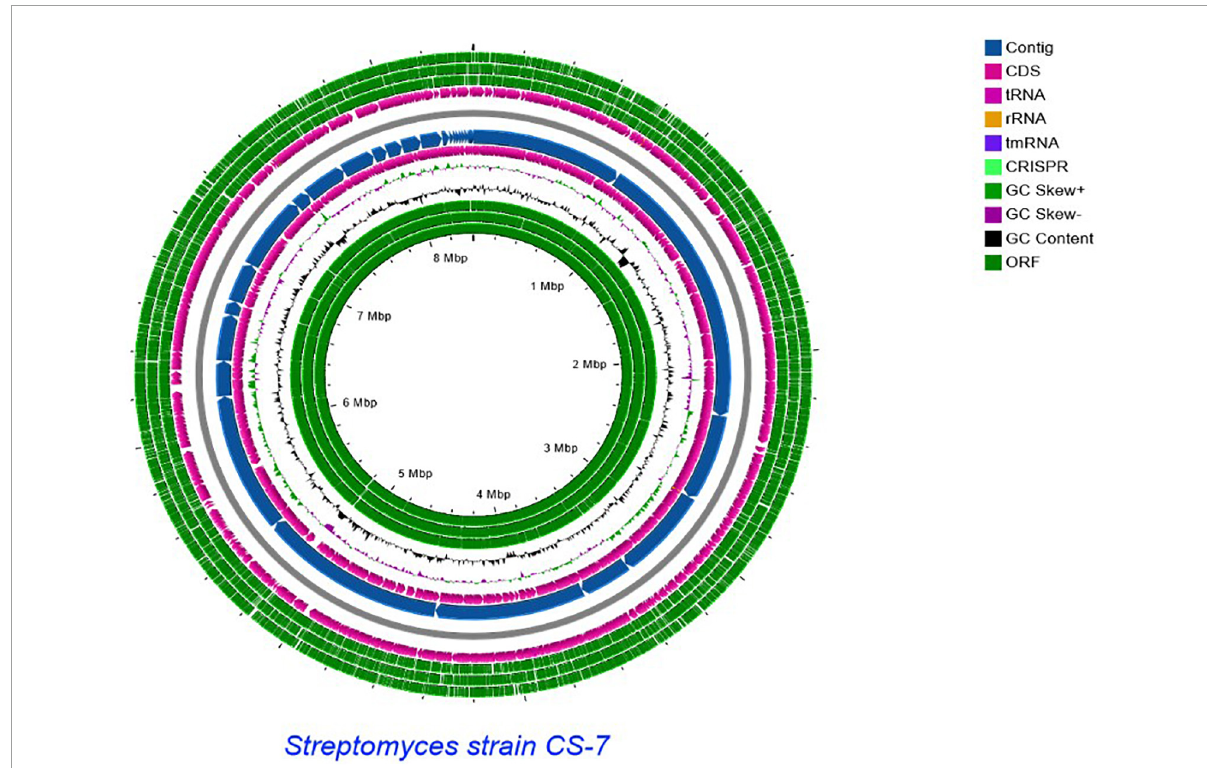
FIGURE6 Schematic representation of the linear chromosome of Streptomyces strain CS-7, created by CG View server (http://cgview.ca/). Circles 1, 2, and 3 display the ORFs. Circle 4 displays the CDS. Circle 6 displays the contigs. Circle 5 displays the tRNA genes. Circle 6 displays the GC percentage plot. Circle 7 displays the GC